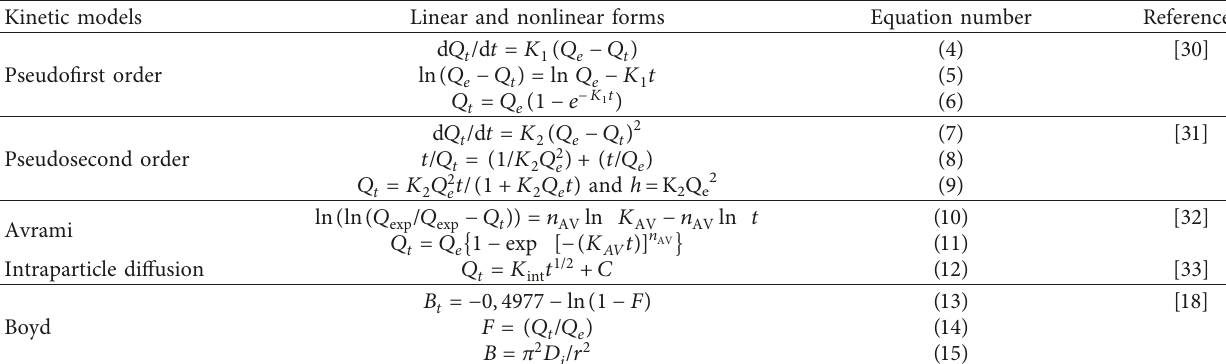
Figure 11: Effect of ionic strength on the adsorption of indigo carmine. Experimental conditions: C pH � 2; t � 80min; speed � 200rpm at room temperature. Table 2: Linear and nonlinear kinetic models. Kinetic models Linear and nonlinear